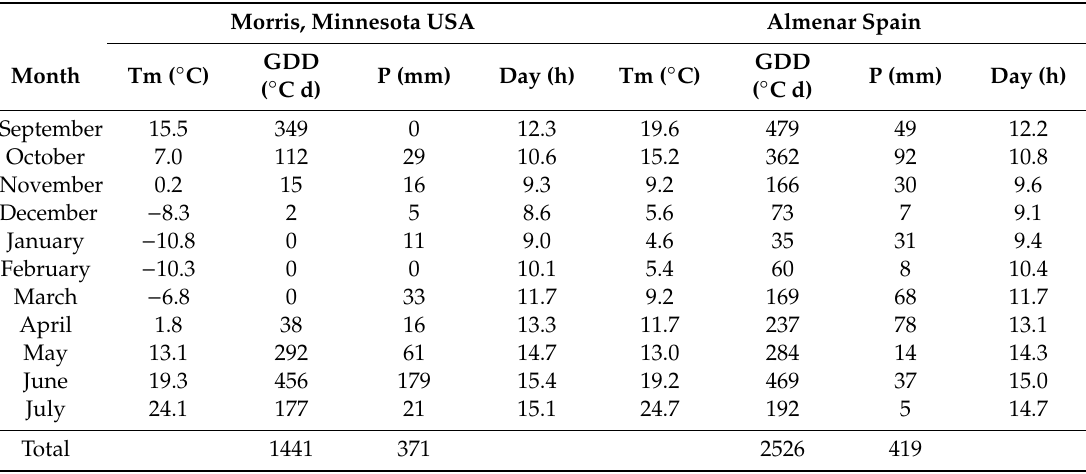
Table 1. Monthly climate data for Almenar, Spain, and Morris, Minnesota USA, during the growing season of pennycress from sowing to harvest in 2012–2013. Tm, mean temperature; GDD, accumulated growing degree days; P, precipitation; Day, mean daylength.